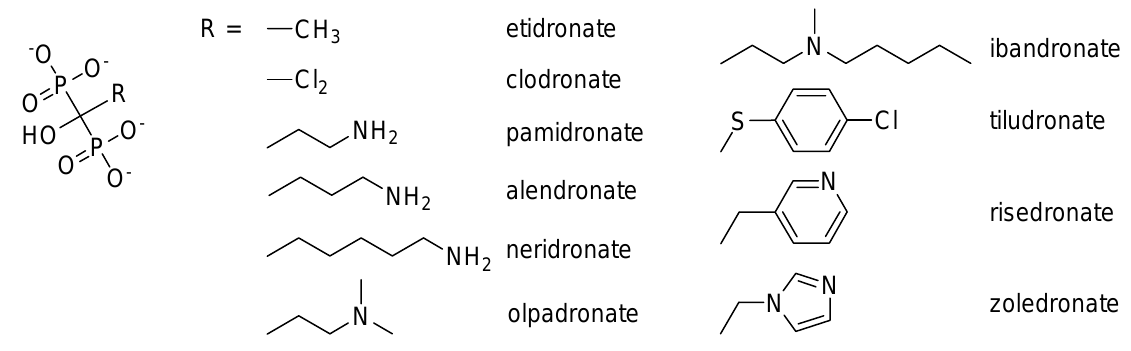
Figure 1. Structures of